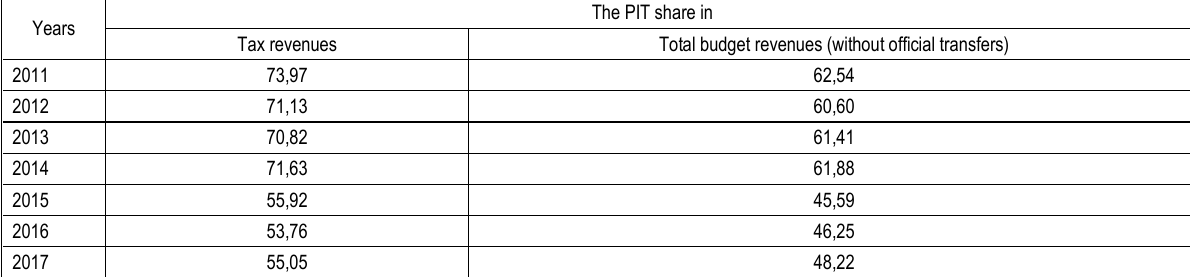
Table 2. The PIT share in the local budget revenues,